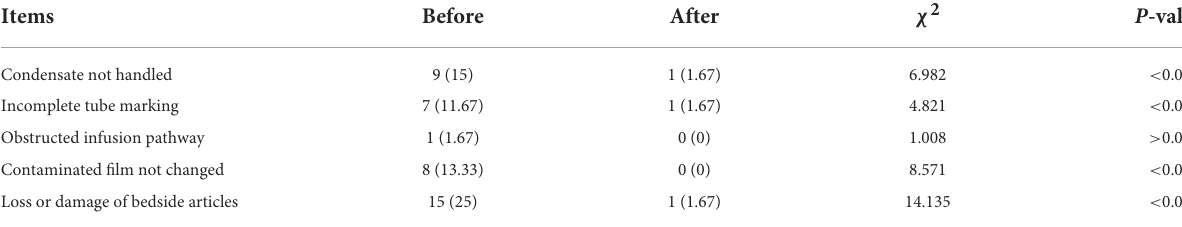
TABLE 4 Comparison of inadequate preparation in nursing handover before and after using checklist [Times